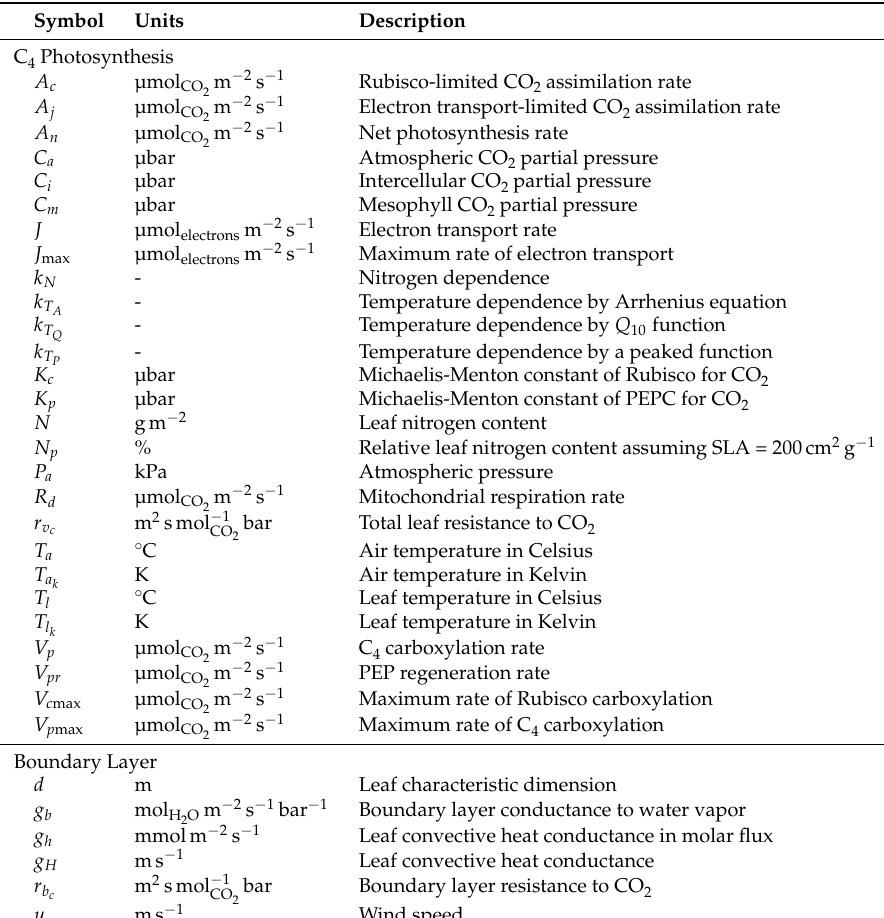
Table A1. Variables declared in the